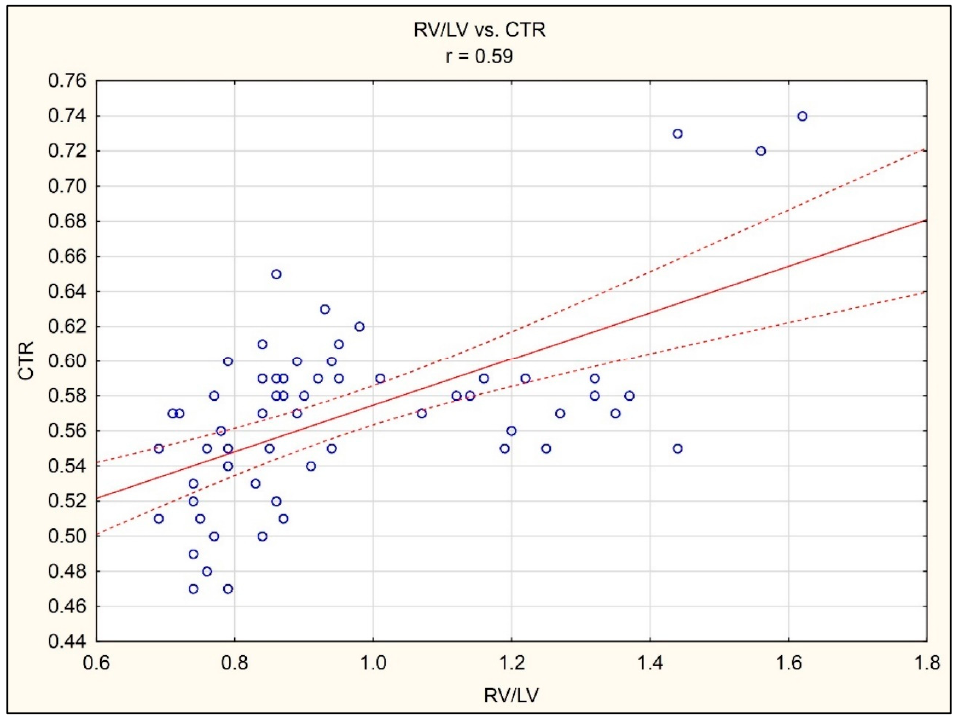
Figure 3. Correlation between RV/LV ratio in CTA of pulmonary arteries and CTR in chest radiograph in the AP projection.